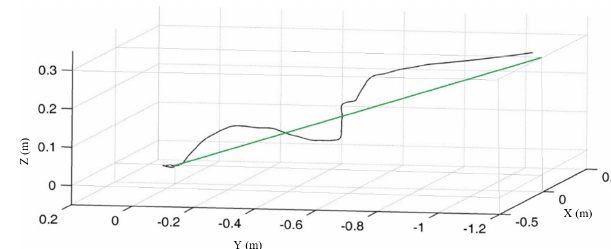
Figure 8. Trajectory of movement in space.